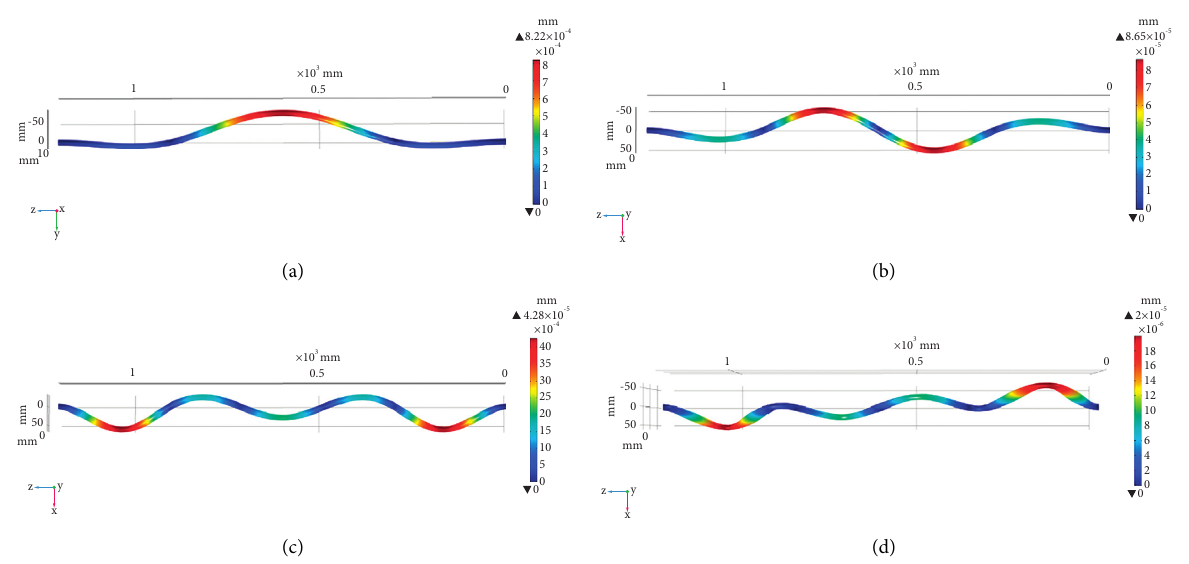
Figure 6: “101” mode. (a) First order. (b) Second order. (c) Third order. (d) Fourth